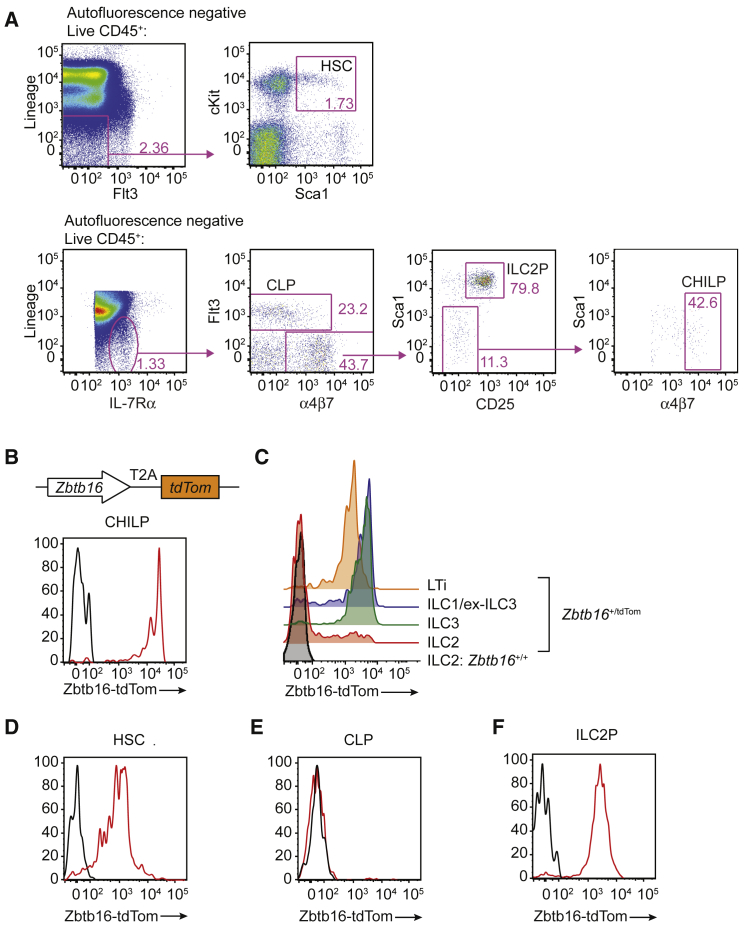
Zbtb16-tdTom Reporter Reveals Fluctuating Expression throughout Hematopoiesis(A) Flow-cytometric gating strategy for HSC, CLP, CHILP, and ILC2P subsets in Zbtb16+/tdTom bone marrow.(B) Flow-cytometric analysis of Zbtb16-tdTom in bone-marrow-derived CHILP (Lin−CD45+IL-7Rα+α4β7hiSca1int/loFlt3−CD25−).(C) Flow-cytometry analysis of Zbtb16-tdTom expression in the ILC subsets in the siLP of Zbtb16+/tdTom mice.(D) Flow-cytometry analysis of Zbtb16-tdTom expression in bone marrow-derived HSCs (Lin−CD45+Kit+Sca1+Flt3−).(E) Flow-cytometry analysis of Zbtb16-tdTom expression in bone-marrow-derived CLPs (Lin−CD45+ IL-7Rα+Flt3+).(F) Flow-cytometry analysis of Zbtb16-tdTom expression in bone-marrow-derived ILC2Ps (Lin−CD45+IL-7Rα+α4β7+Sca1hiFlt3−CD25+).Data are representative of 2 independent experiments. Please also see Figure S5.